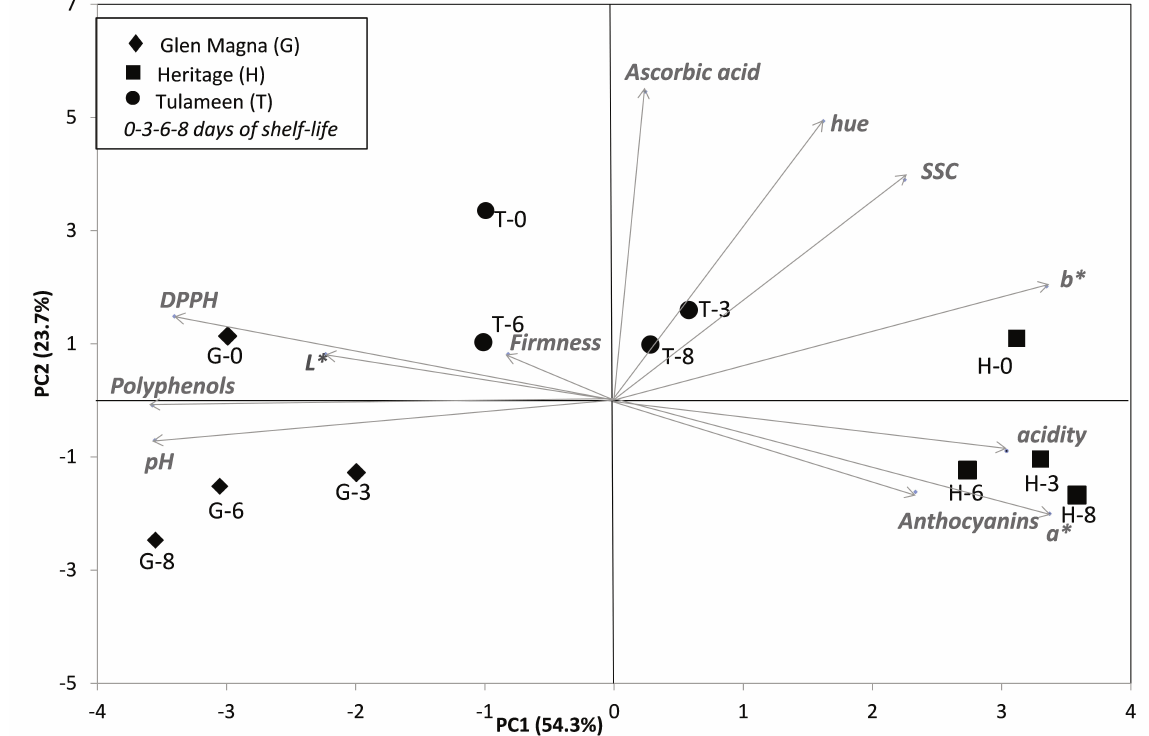
Fig. 2 - PCA biplot of quality and nutritional parameters during shelf-life of ready-to-eat raspberry fruit from the cultvars Heritage (H), Tulameen (T) and Glen Magna (G) after 0(raw)-3-6-8 days of shelf-life at 3°C (SSC=soluble solids content; L*, a*, b*, hue=colour parameters; DPPH=Scavenging